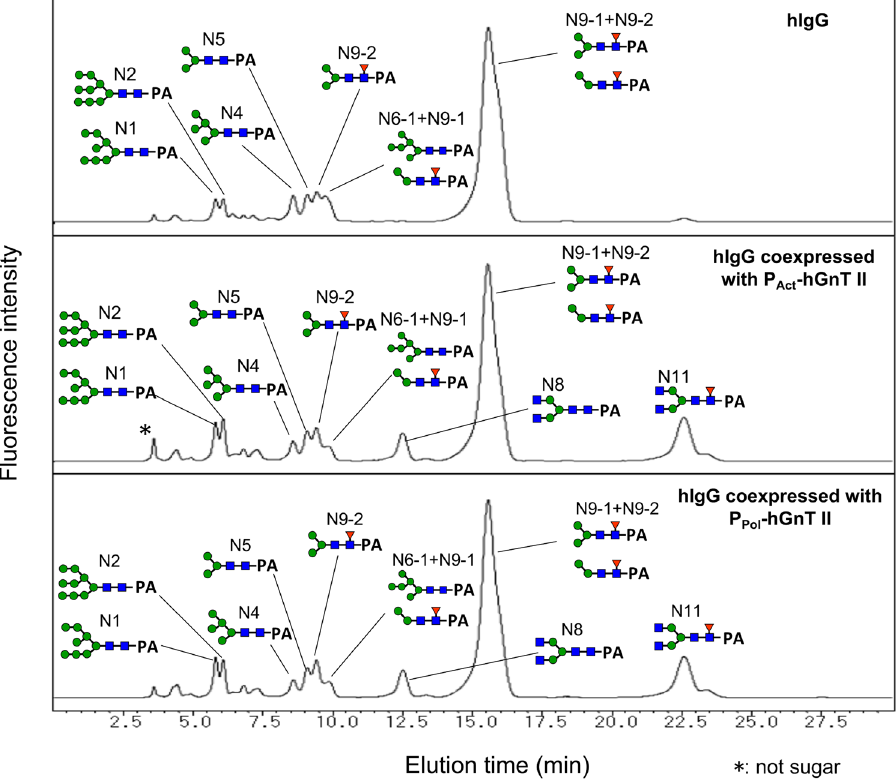
Figure 3. Chromatograms of PA-derivatized N -glycans derived from recombinant IgG coexpressed with hGnT II in silkworms, as determined via ODS column chromatography. N1 to N11 are the numbers of N -glycans, as shown in Fig.